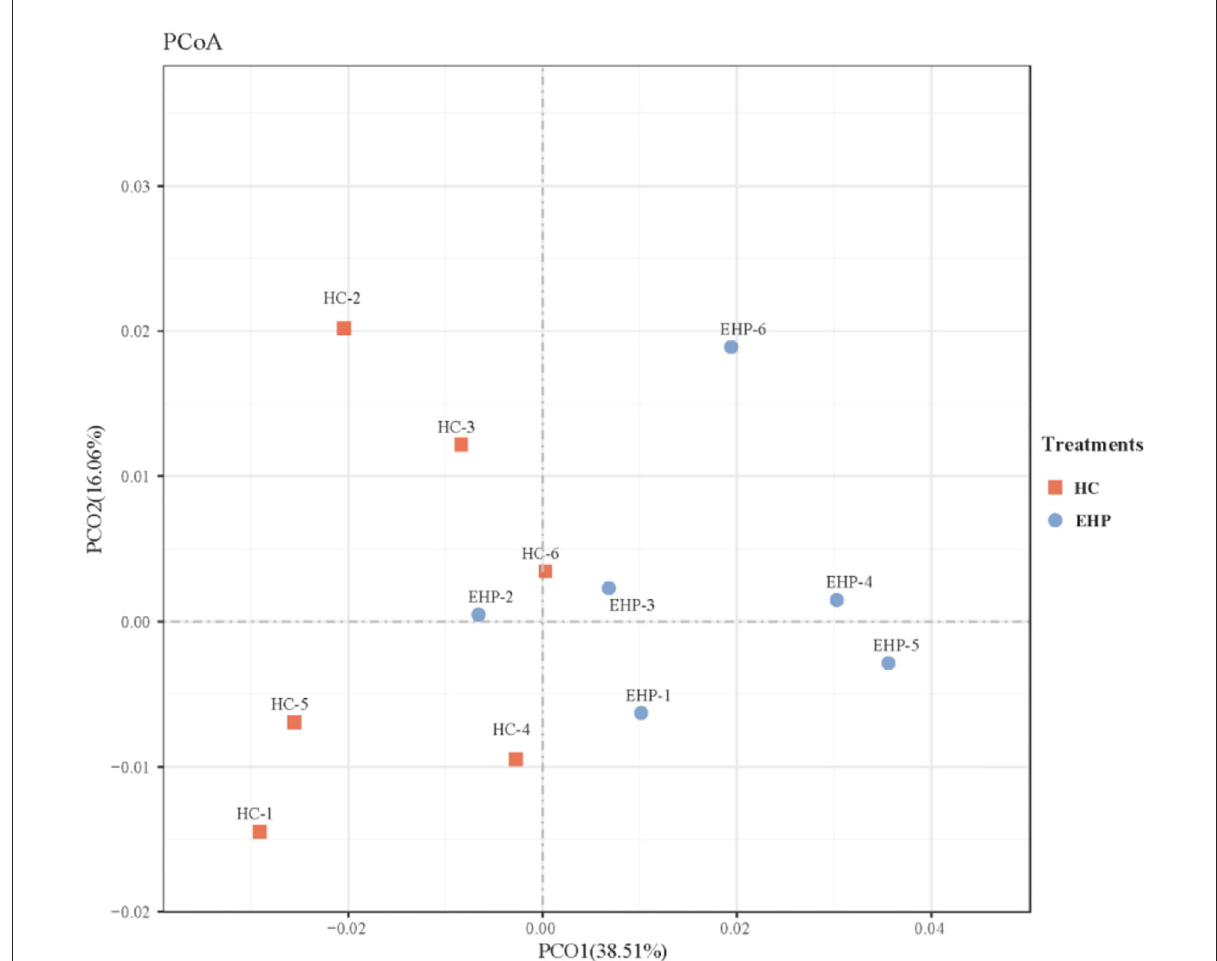
FIGURE1 Principal coordinate analysis (PCoA) on community structures of the rumen microbiota between small peptide supplement and high-concentrate diet treatments. HC, high-concentrate diets; EHP, enzymatic hydrolyzed cottonseed